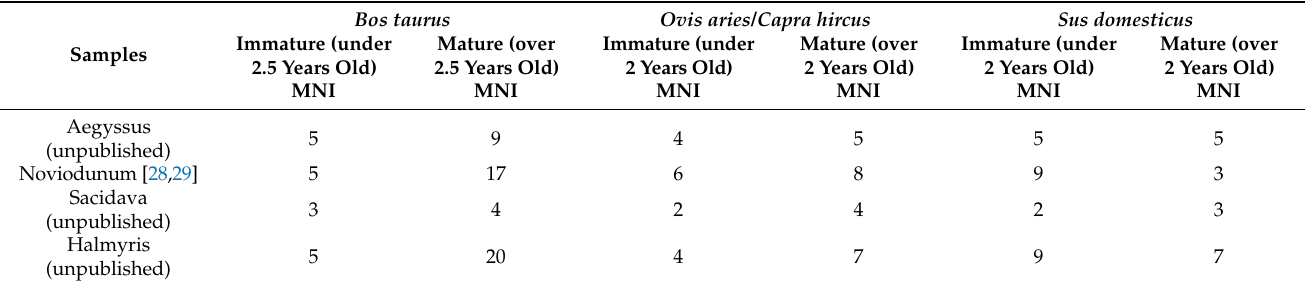
Table 6. Dental age of slaughter for estimated individuals of Bos taurus (cattle), Ovis aries/Capra hircus (sheep/goat), and Sus domesticus (pig) (MNI—minimal number of individuals). Bos taurus Ovis aries/Capra hircus Sus domesticus Immature (under Mature (over Immature (under Mature (over Immature (under Mature (over Samples 2.5 Years Old) 2.5 Years Old) 2 Years Old) 2 Years Old) 2 Years Old) 2 Years Old) MNI MNI MNI MNI MNI